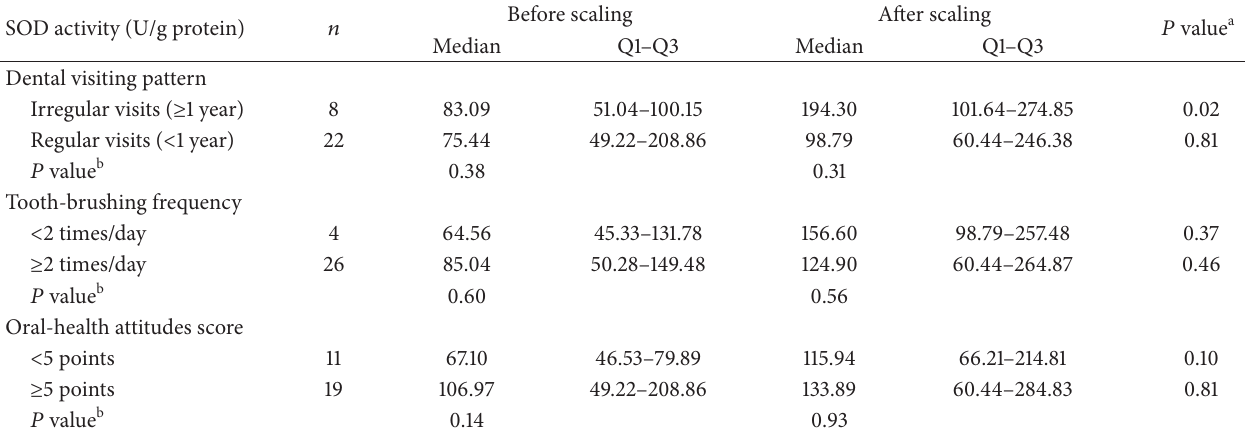
Table 2: Comparison of superoxide dismutase (SOD) activity between oral-health behavior and attitude